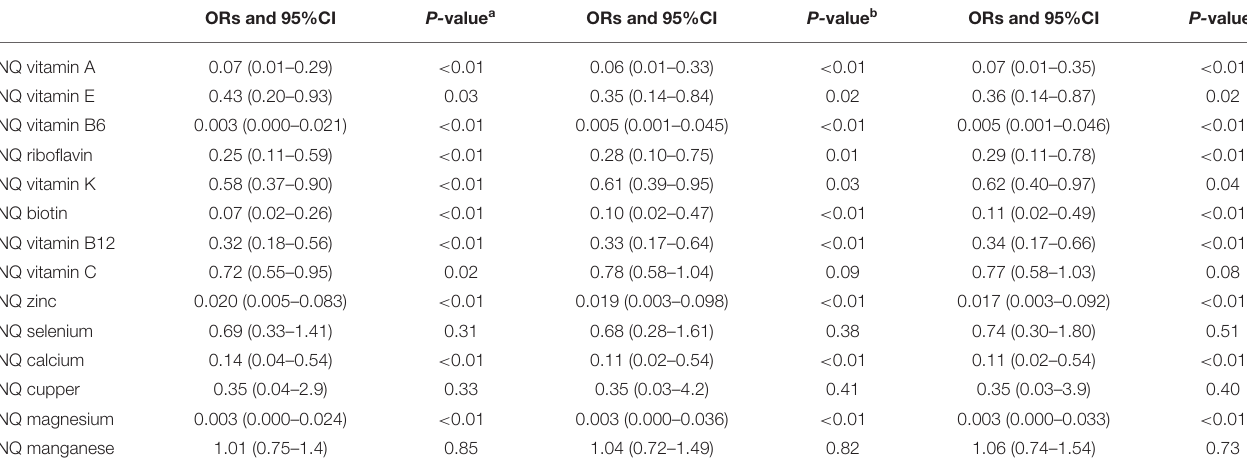
TABLE 4 | The association between breast cancer and the index of nutritional quality (INQ). ORs and 95%CI P- value a ORs and 95%CI P- value